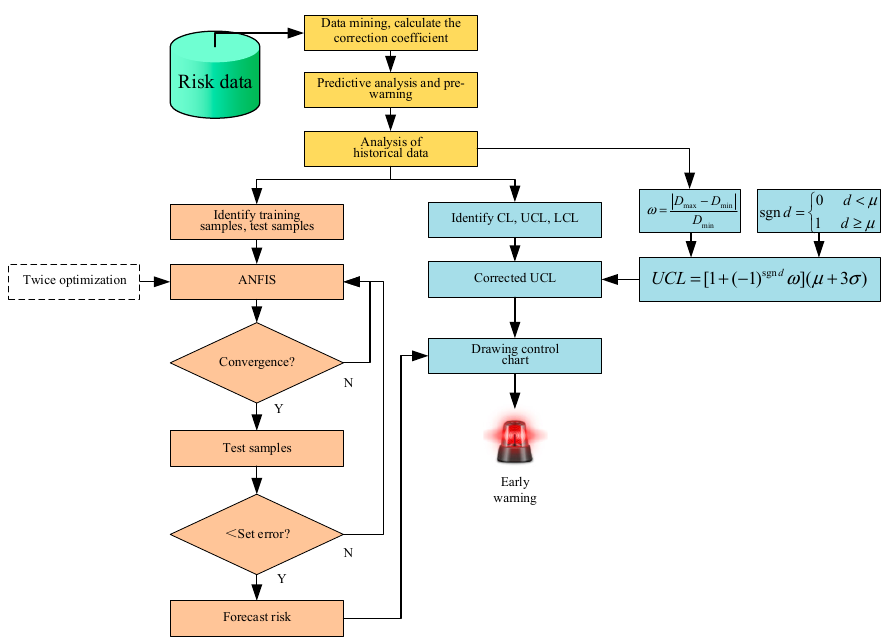
Figure 3. Early warning mechanism of coal mine